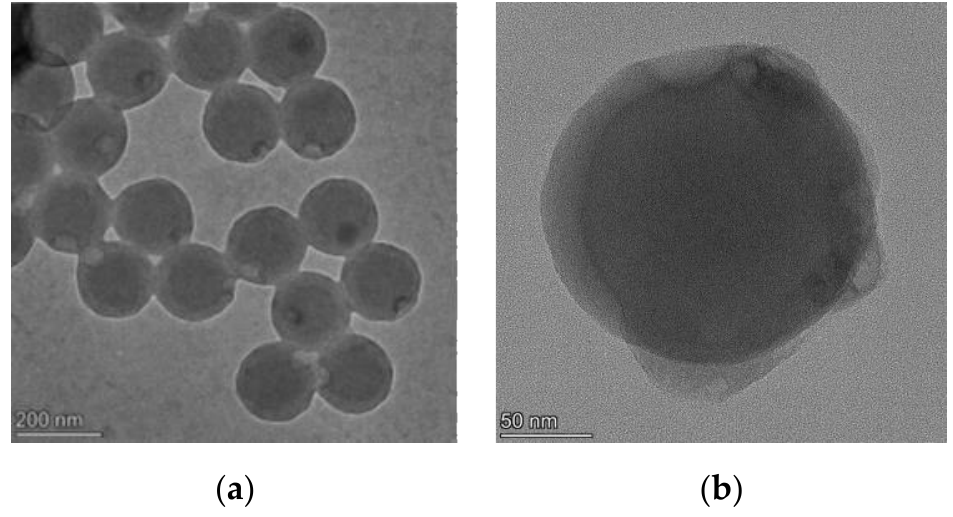
Figure 5. Scanning electron microscope image of fluorescent microsphere. ( a ) Scanning electron microscope image of 200 nm size; ( b ) Scanning electron microscope image of 50 nm size.